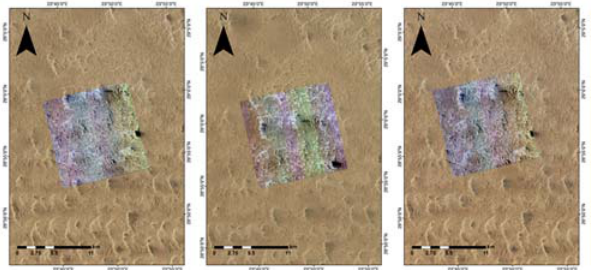
Figure 2. K3A and L8 Libya-4 Site Image for Cross